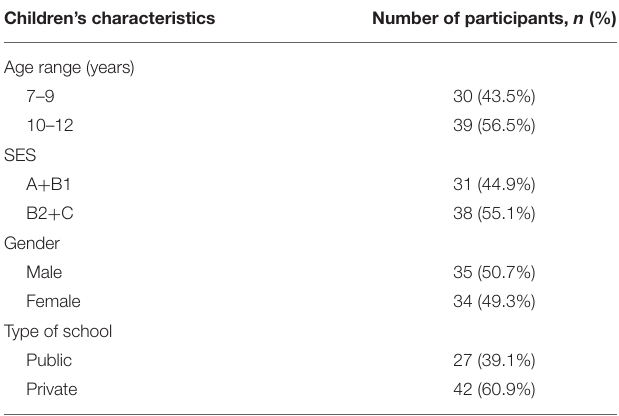
TABLE 1 | Characteristics of the participants ( n = 69). TABLE 2 | Themes, subthemes, and codes that emerged through content analysis of nine focus groups in São Paulo,